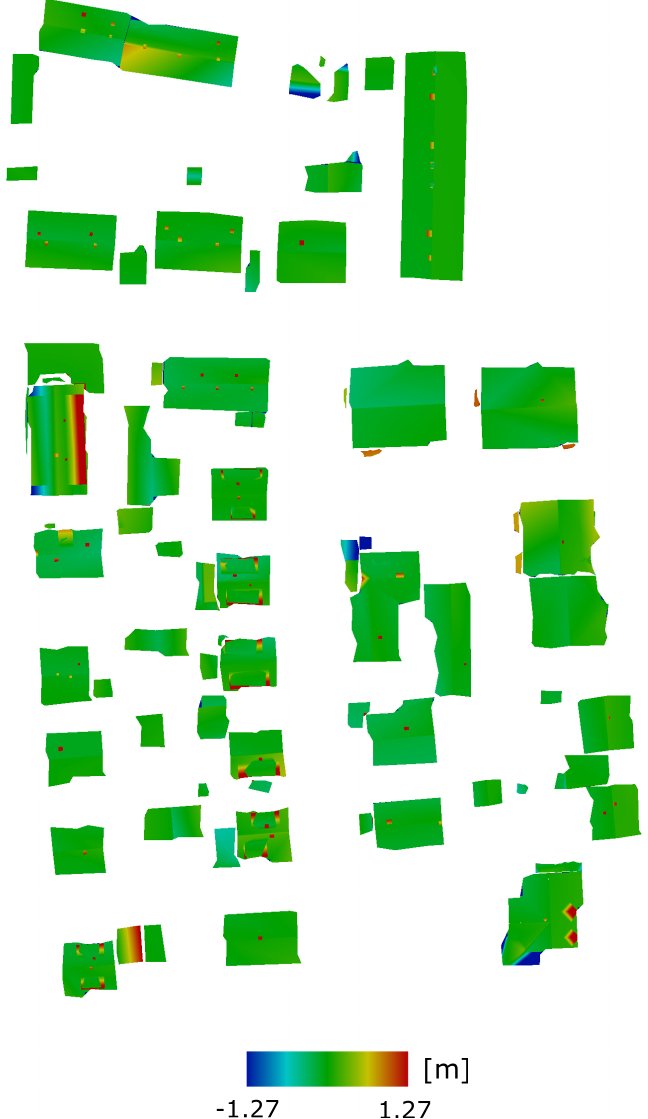
Figure 9. Height difference comparison of the output of the proposed algorithm with the ground-truth data of the ISPRS